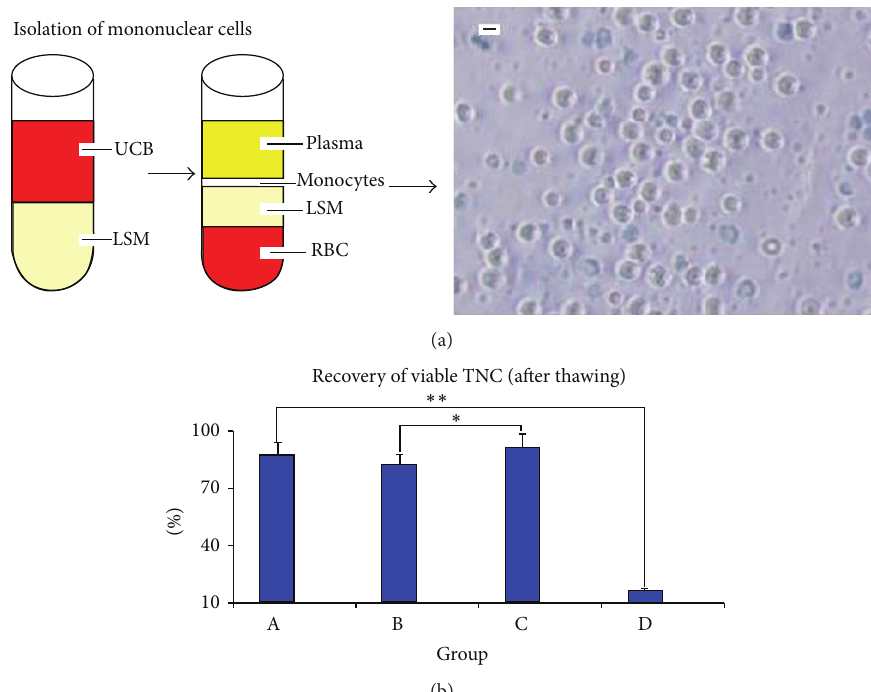
Figure 1: (a) The mononuclear cells were separated from UCB by density gradient centrifugation. (b) Recovery of viable TNC (after thawing): the viable TNC recovery of group C was higher than that of either groups A, B ( 𝑃 < 0.05 ) or group D ( 𝑃 < 0.01 ). The recovery of group D was lower than that of either group A, B, or C ( 𝑃 < 0.01 ). Scale bars: 5 𝜇 m.